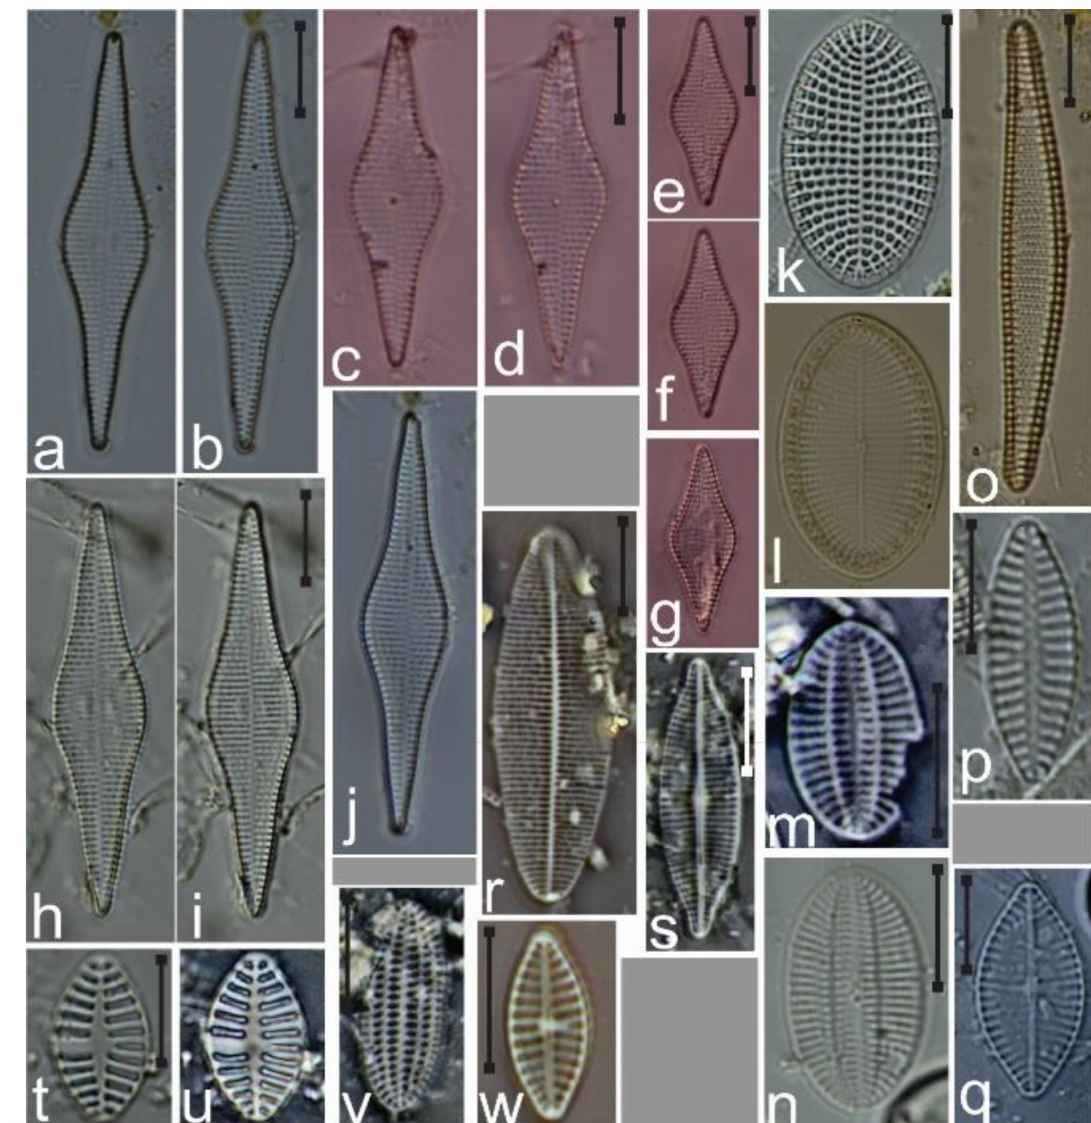
Figure 25. ( a – j ) Glyphodesmis rhombica valves at di ff erent focal planes and showing range in size; ( k , l ) Cocconeis scutellum sternum and raphe valves, respectively; ( m , n ) C. peltoides ; ( o ) Fragilariopsis doliolus ; ( p ) Planothidium lilljeborgei sternum valve; ( q , t , u ) P. delicatulum raphe and sternum valves; ( r ) P. polare sternum valve; ( s ) P. campechianum raphe valve; ( v ) Amphicocconeis discrepans sternum valve; ( w ) Planothidium hauckianum raphe valve. Scale bar = 10 µ